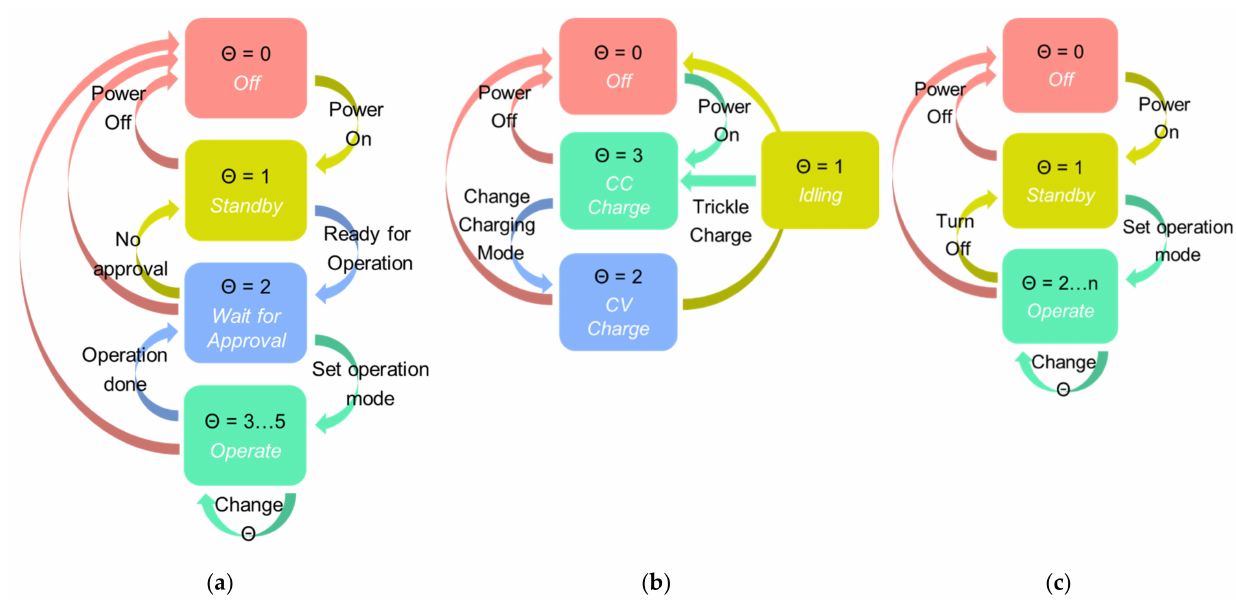
Figure 1. ( a ) State transition diagram of the stacker crane including the decoding. To operate, the machine must pass the ‘ standby ’ mode and wait for an approval before it can switch to the ‘ operate ’ mode. If the operation is completed, the machine switches back to the ‘ wait for approval ’ mode. If no approval is given, it switches back to the ‘ standby ’ mode. ( b ) State transition diagram of the automated guided vehicle. It is not allowed to switch from the ‘ CV charging ’ mode to the ‘ CC charging ’ mode. Another infeasible transition is to switch from ‘ idling ’ mode to the ‘ CV charging ’ mode. Furthermore, to reach the ‘ CV charging ’ mode starting from the ‘ off ’ mode, first the ‘ CC charging ’ mode has to be set. The ’ off ’ mode can be accessed from all states. ( c ) Valid state transition diagram for the electrical saw, Robot 1 and Robot 2. Starting with the operation mode ‘ off ’, it is only allowed to switch to the operation mode ‘ standby ’. From there, all other modes can be accessed. It is possible to jump to the ‘ off ’ mode from any other operating mode.